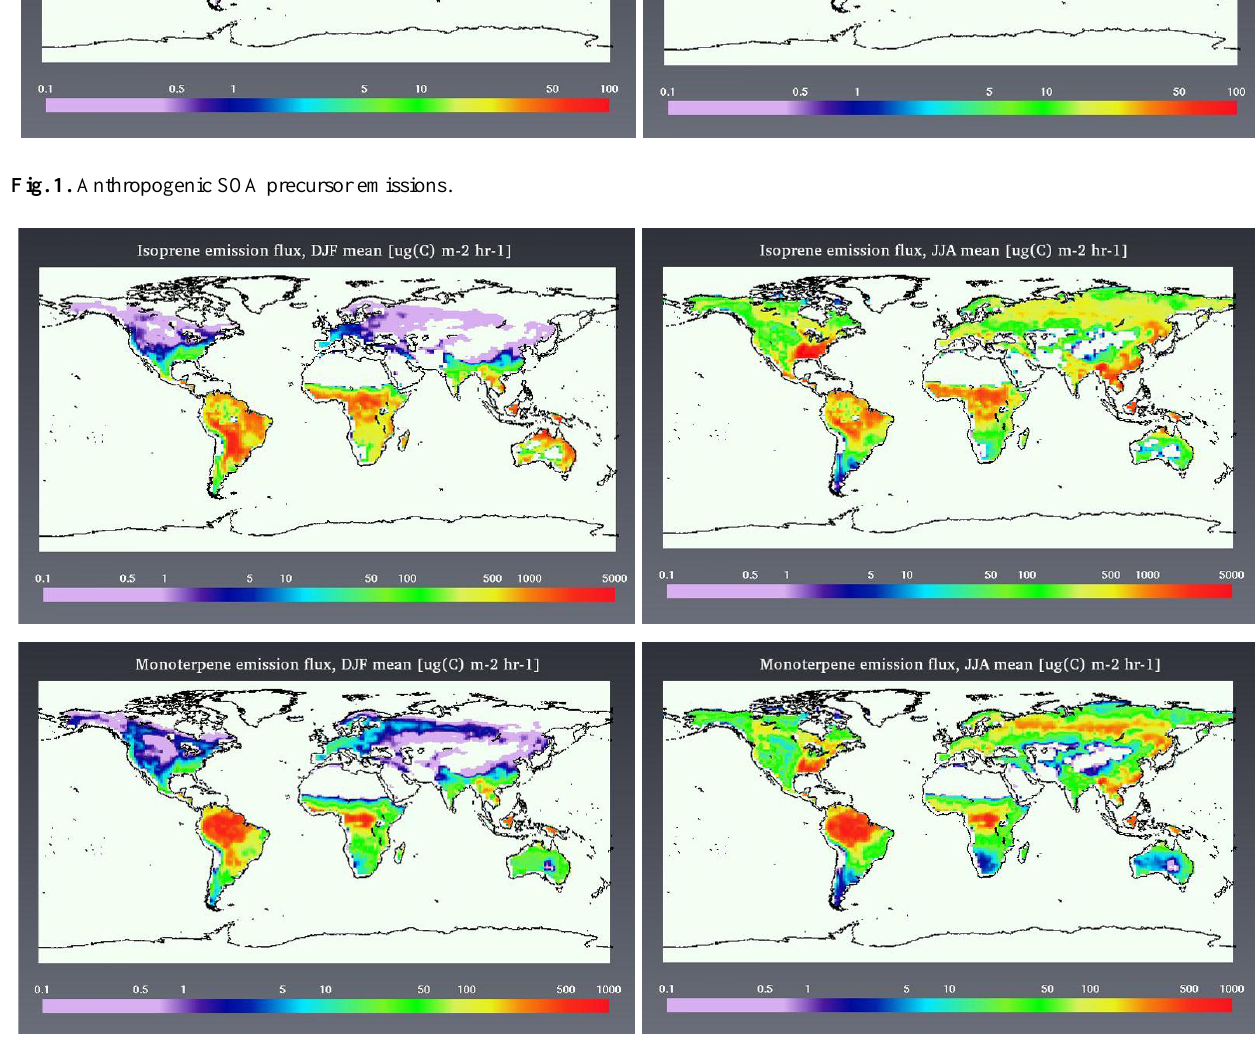
Figure 2. Seasonal variations of biogenic emissions